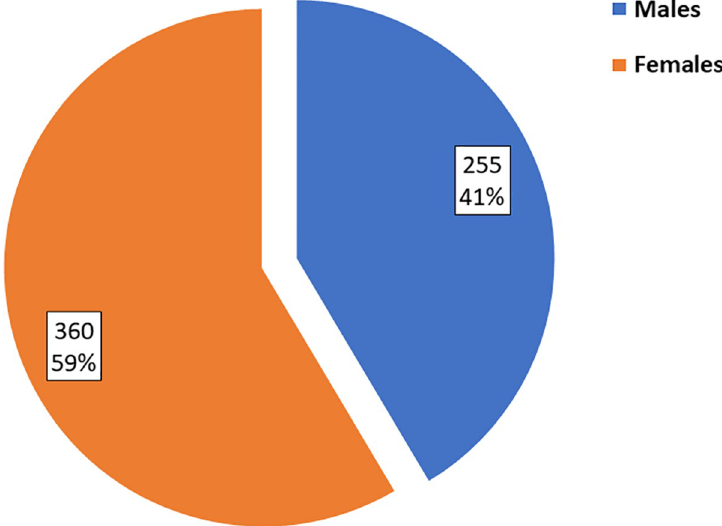
Fig 2. Pie chart for gender distribution of patients included in the study. Inclusion criteria was a final diagnosis of an autoimmune bullous diseases regardless of age or gender.